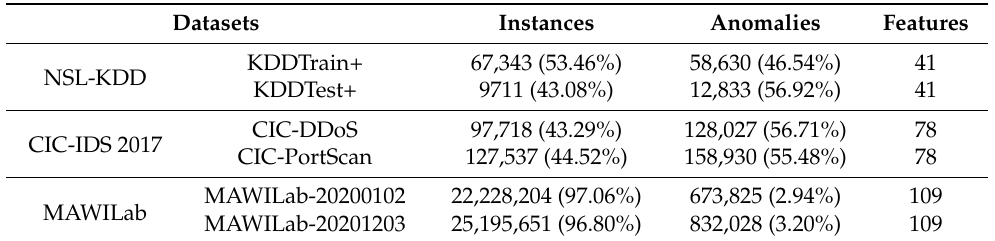
Table 1. Summary of the datasets used in the